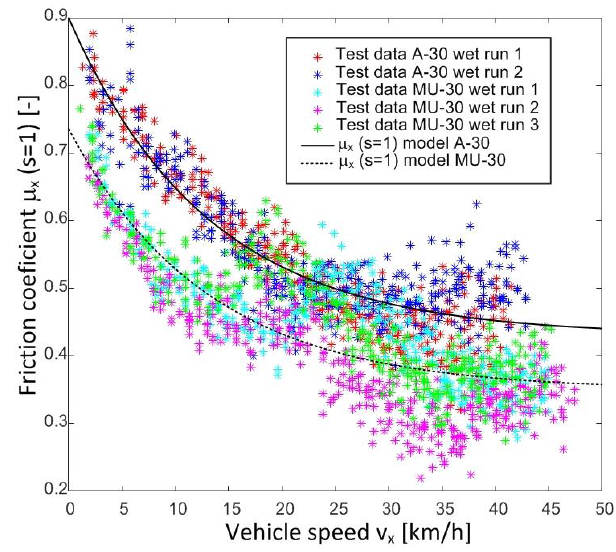
Figure 4. Friction coefficient vs vehicle speed. A-30 and MU-30 roads. Wet asphalt.